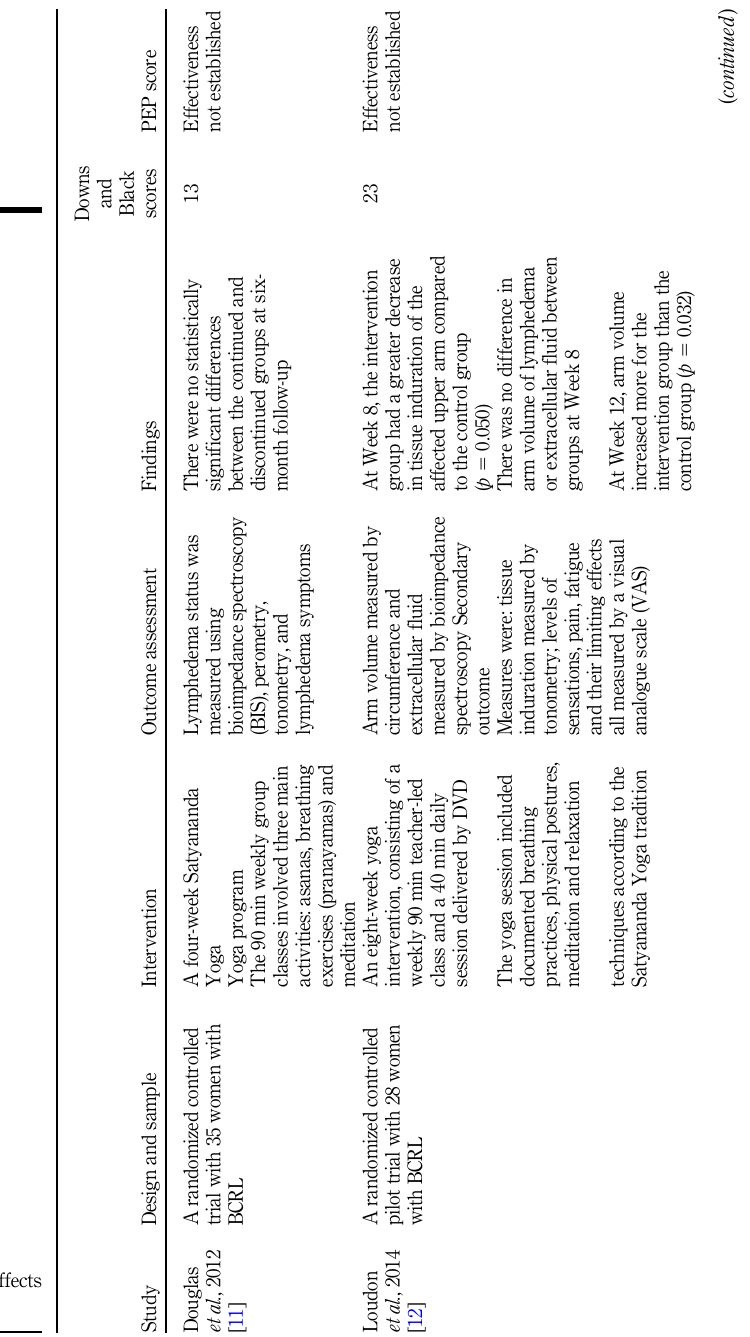
Table 1. Summary of the effects of yoga on